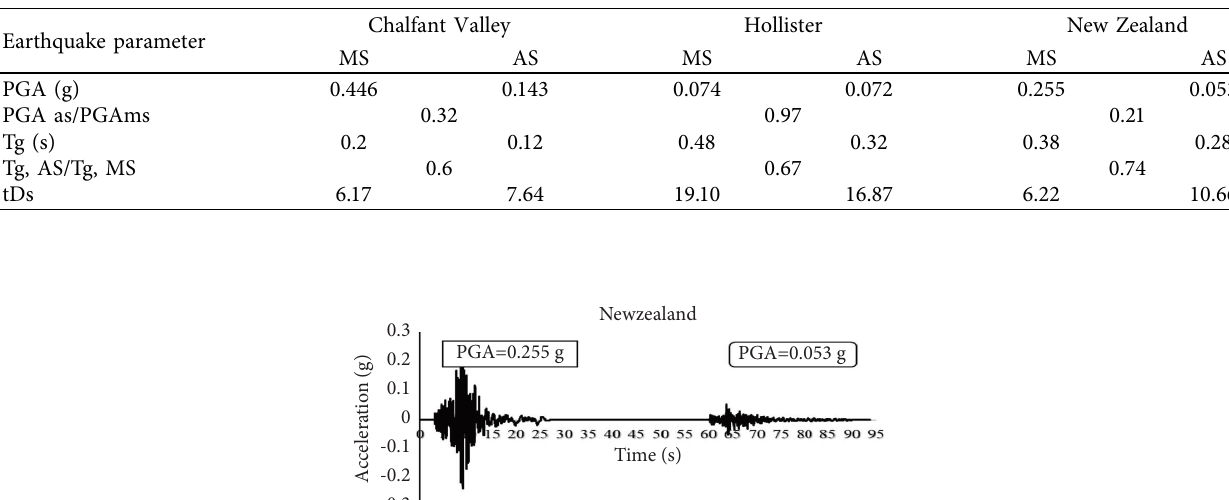
Table 14: Parameters and efective characteristics in the response of models under Group I.